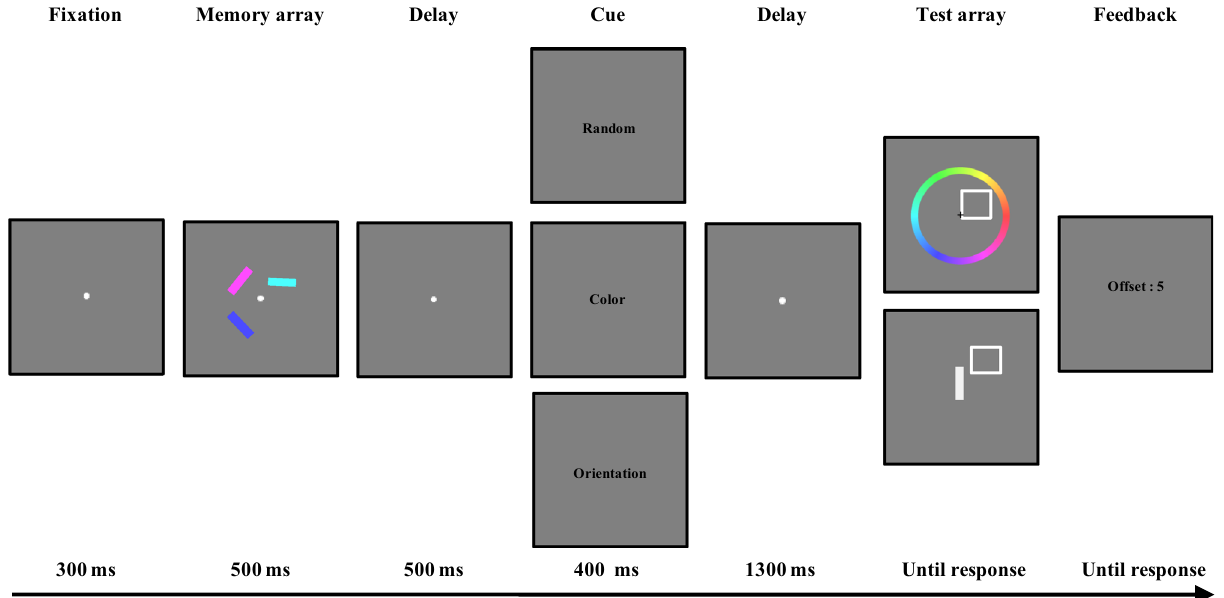
Figure 2. The task structure for the dimension-based cue task. The cue type in the upper row indicates the neutral retrocue, while the cue types in the middle and lower rows indicate the valid retrocues. For the test array, the upper row represents the color report trials, and the lower row represents the orientation report trials.